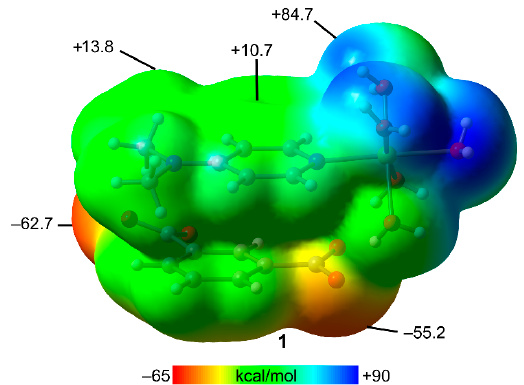
Figure 12. MEP surface of [Ni(H 2 O) 5 (DMAP)](IPhth) at the RI-BP86-D3/def2-TZVP level of theory (isosurface 0.001 a.u.). Energies in kcal/mol.